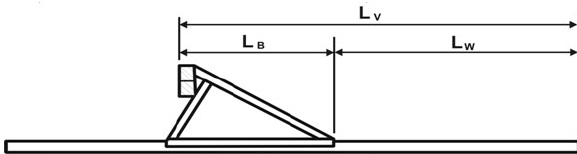
Figure 2. Length needed for buffer stop placement